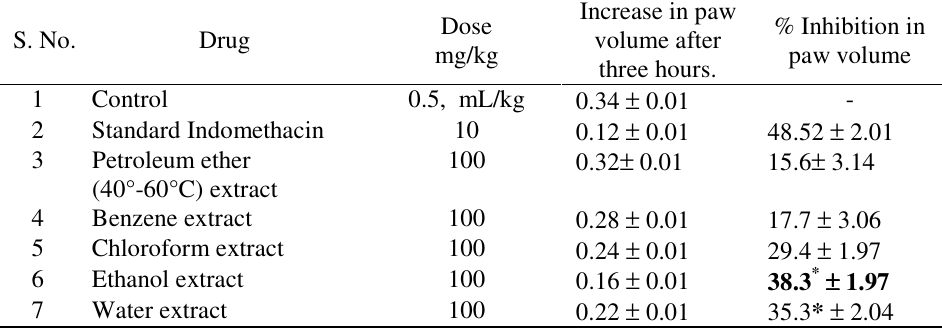
Table 1 . Preliminary pharmacological screening of M . tridentata extracts on carrageenan induced rat hind paw oedema S.